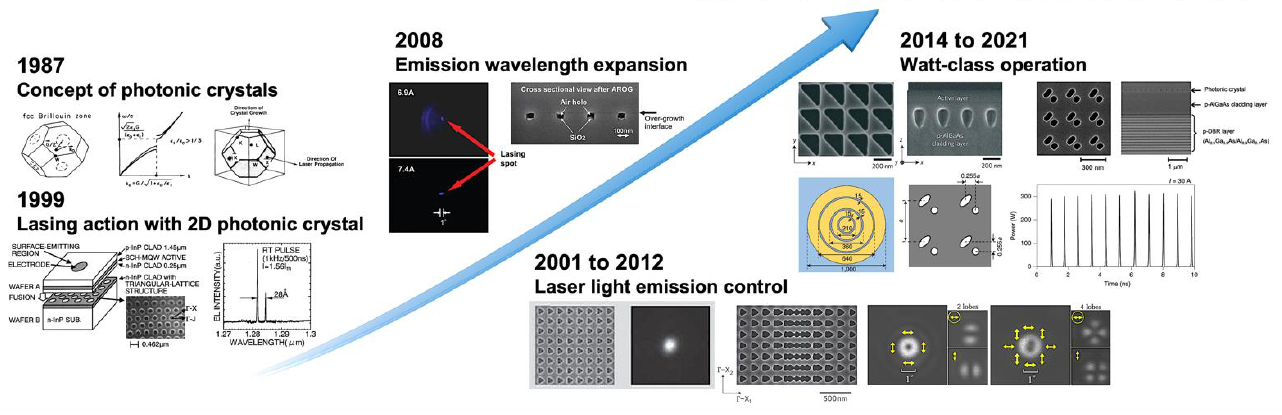
Figure 9. Development progress of PCSEL technology toward an ultracompact ToF LiDAR system